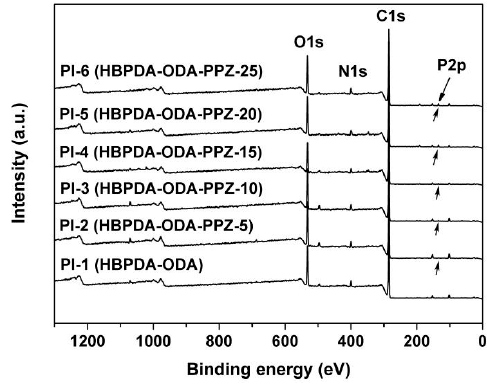
Figure 3. XPS spectra of PI films.